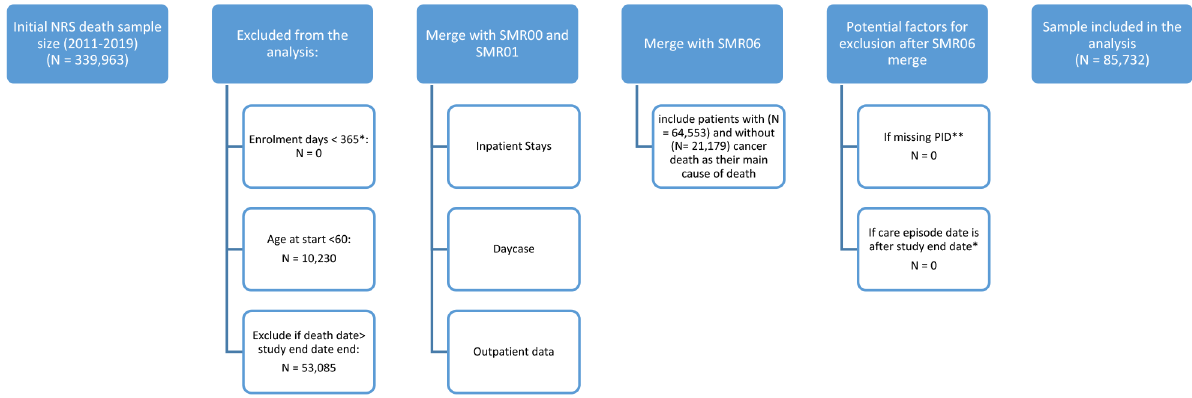
Supplementary Figure 1: Flow chart of datalinkage & inclusion/exclusion criteria